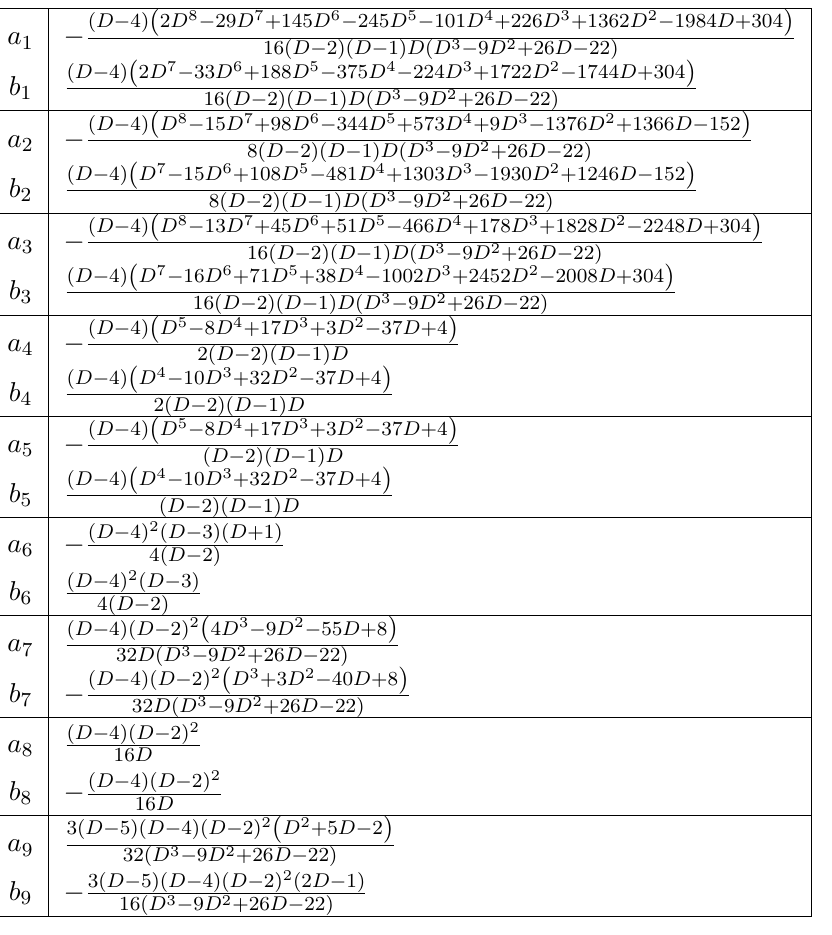
Table 5. Coefficients a , b of the shear viscosity contribution from quartic ETQT terms. Each entry corresponds to the solution with the same index in table 2. Entries with zero coefficients are omitted.